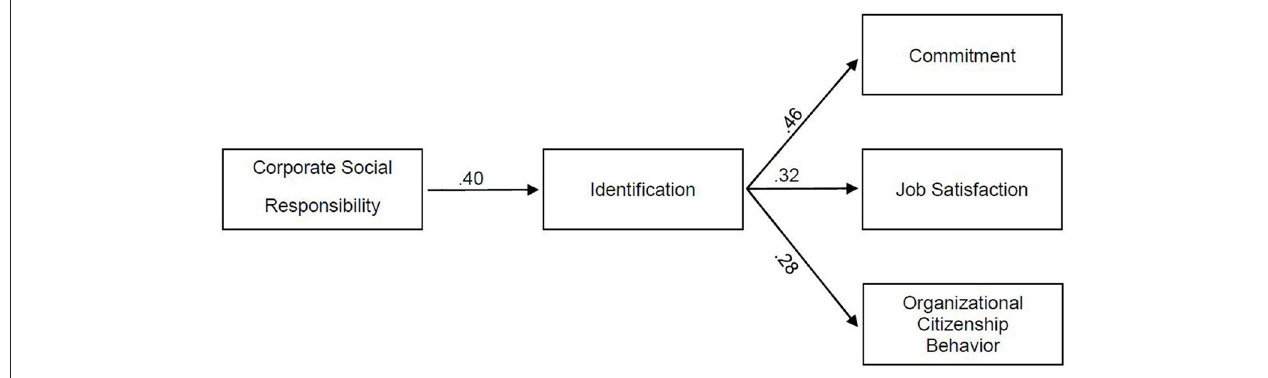
FIGURE 5 | Meta-analytical structural equation model for the relationships between CSR, identification, and commitment, job satisfaction and OCB as employee-related attitudes and